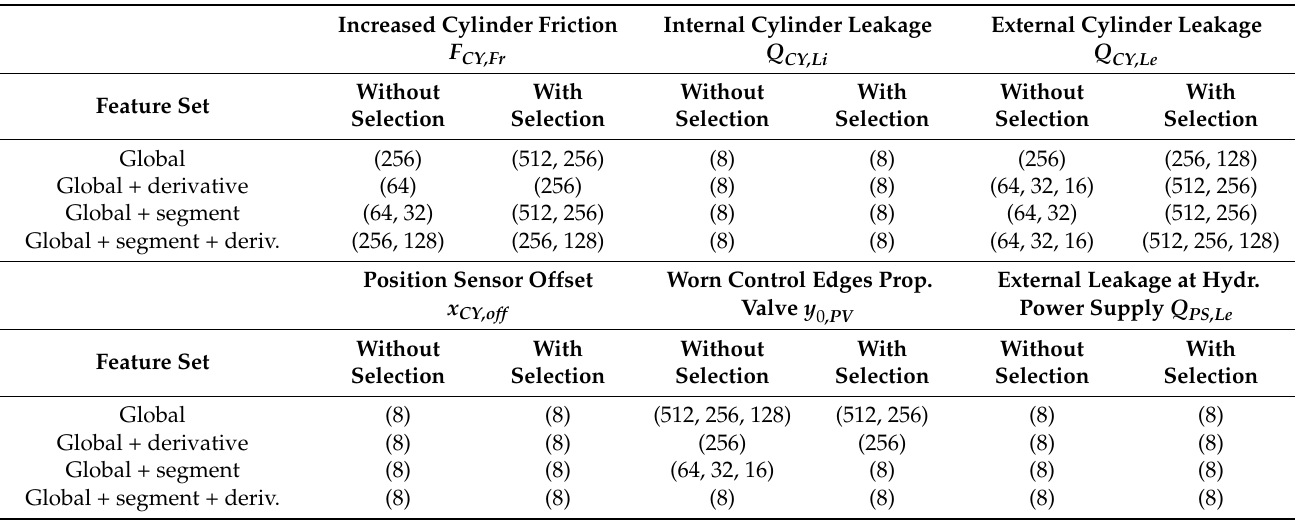
Table 3. Structure of the hidden layers of the best models obtained from the grid search with and without feature selection, for different feature sets and for different faults.